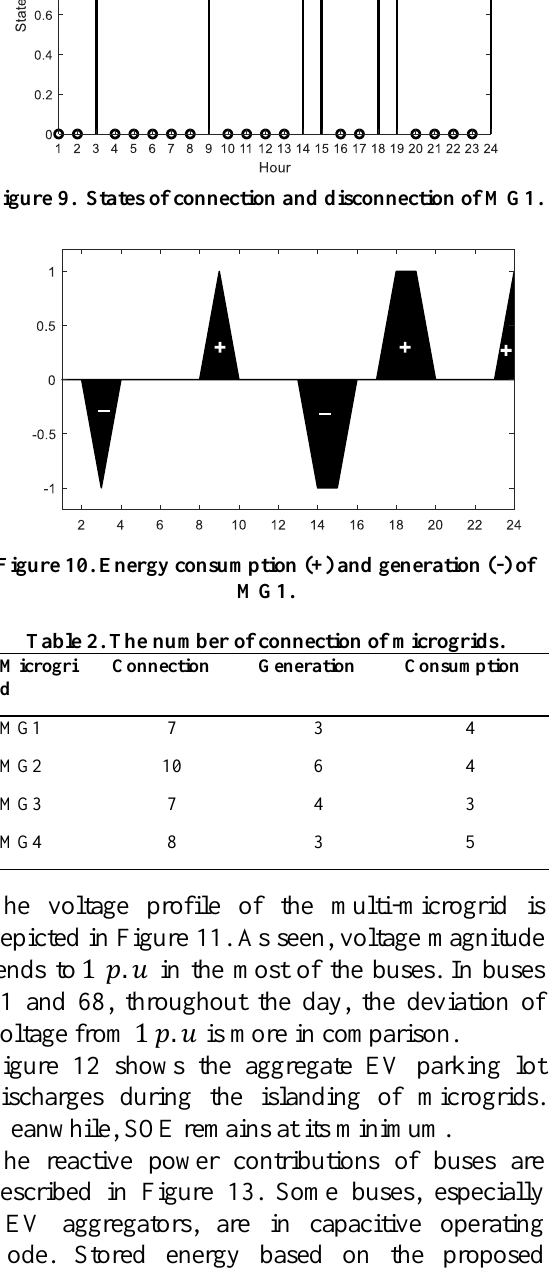
Figure 11. Daily Voltage Profile.